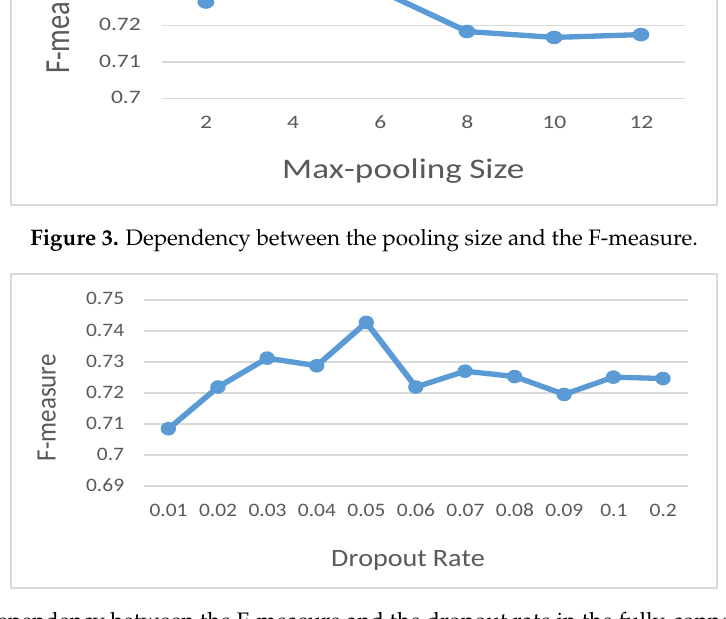
Figure 4. Dependency between the F-measure and the dropout rate in the fully-connected layers. The number of convolution feature maps : The number of feature maps (filters) in both convolution layers were continuously changing. The dependency between the number of feature maps and the F-measure of the model is shown in Figure 5.